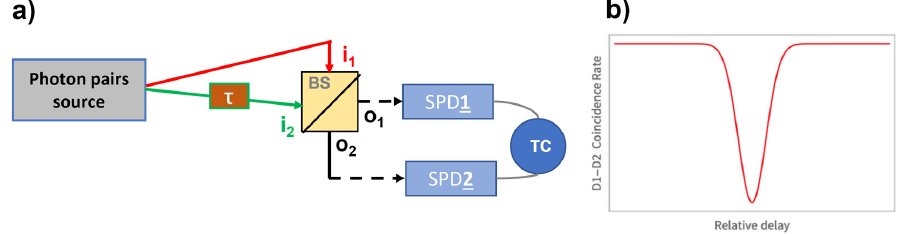
Figure 5. ( a ) Schematic of the HOM set up for characterizing the indistinguishability of the photons. There are a beamsplitter (BS), two single photon detectors (SPD1, SPD2), a time delay line ( τ ) and electronics for coincidence counting and readout (TC). i 1 ,i 2 : beam splitter input ports; o 1 ,o 2 : beam splitter output ports. ( b ) An example of HOM dip.